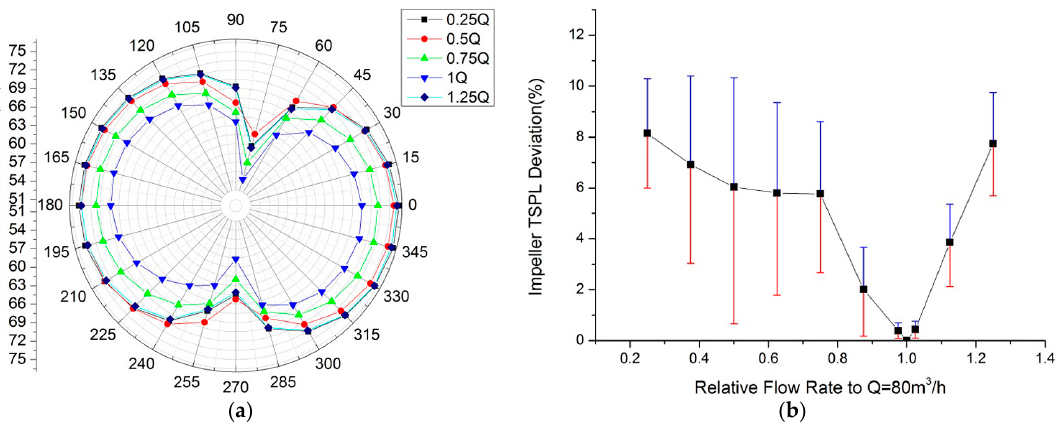
Figure 9. Impeller radiation noise. ( a ) Total sound pressure level ( TSPL ) of directivity field from the impellers; and ( b ) the relationship of TSPL deviation vs. the flow rate.